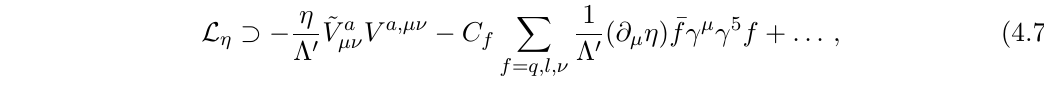
Figure 5 . The evolutions of Y Z 0 ( x ) (red dashed line) and Y X ( x ) (red solid line). The black dotted line is given by the approximate solution. The vertical gray dashed lines indicate the x f for DM particle. Left panel: Higgs-portal model with parameters, m X = 3 TeV, r 1 / 2 1 . 3 , g D = 1 . 24 , t (cid:15) = 10 − 11 , ξ eff = 1 . 5 × 10 − 3 . Right panel: ALP-portal model with parameters, m X = 2 . 5 TeV, r 1 / 2 = 1 . 3 , g D = 1 . 0 , m X / Λ 0 = 0 . 036 , t (cid:15) = 10 − 11 , ξ X = ξ Z 0 = 10 − 5 XZ 0